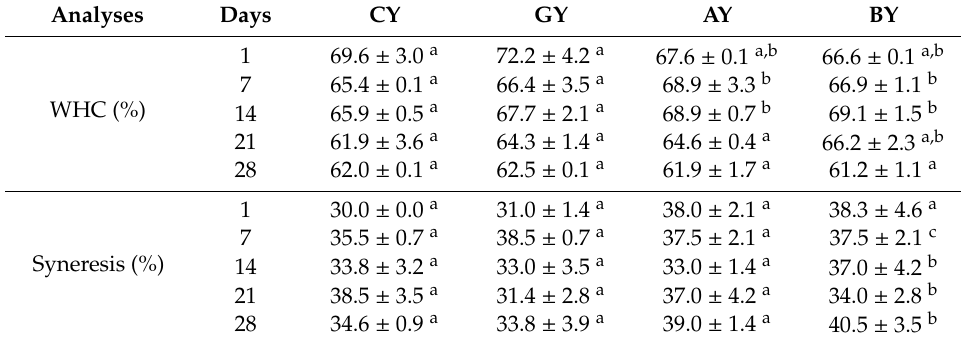
Table 2. E ff ect of storage on water holding capacity (WHC) and syneresis of yogurts.